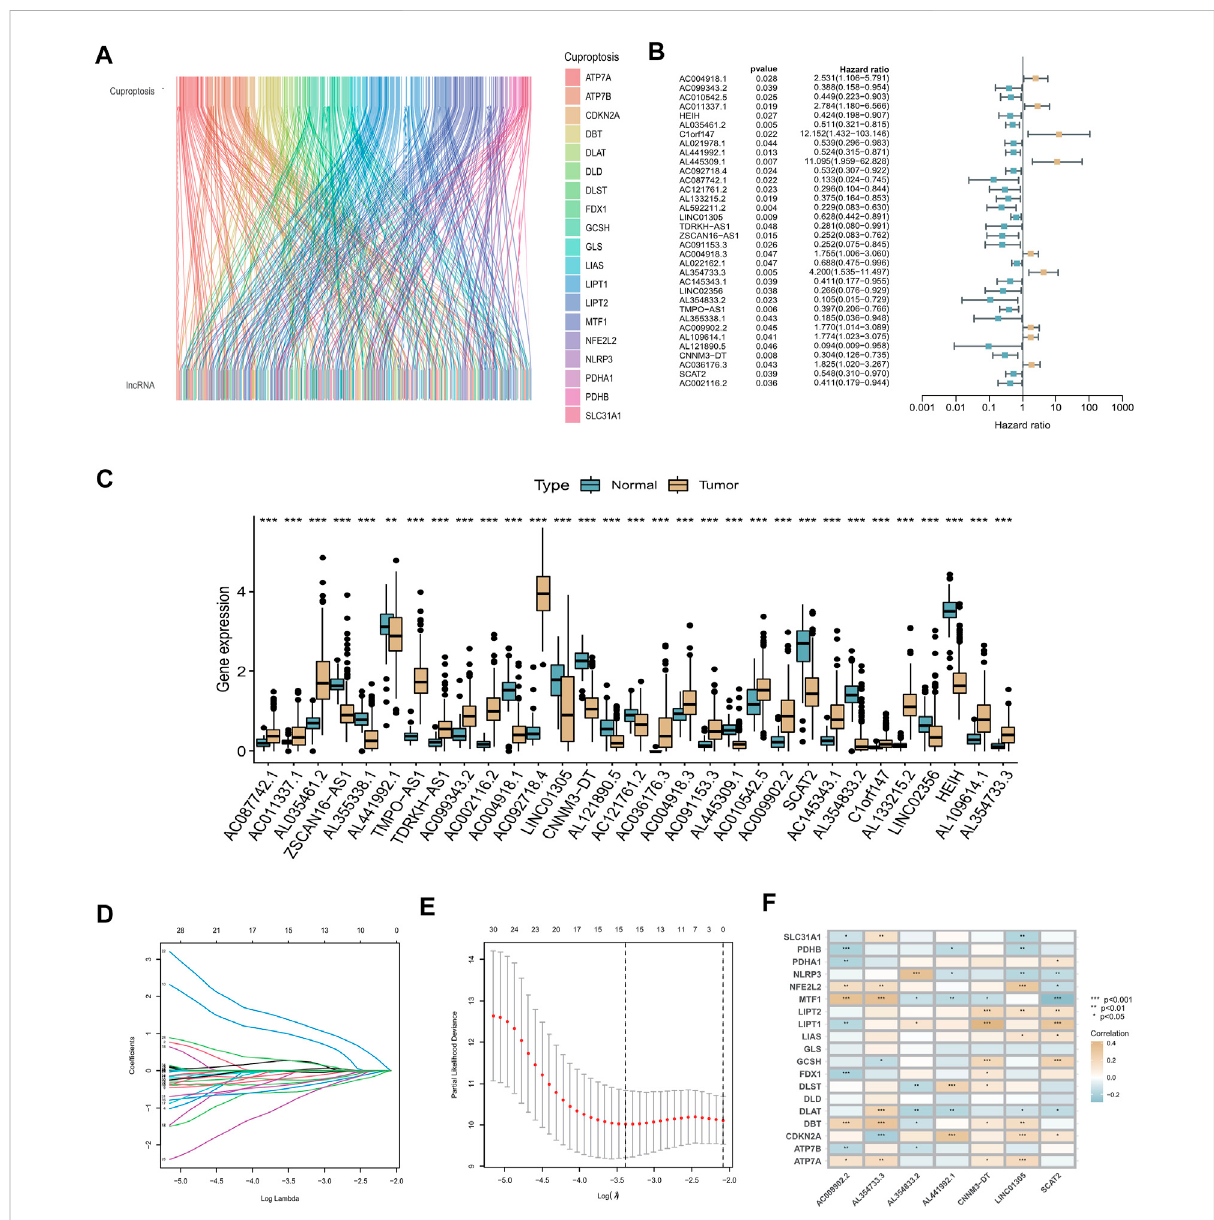
FIGURE 2 Construction of cuproptosis-related lncRNA prognostic signature. (A) Sankey diagram used to visualize the co-expression network of cuproptosis-related lncRNAs. (B) Forest plot representing the results of the univariate Cox regression analysis. (C) Expression levels of 34 cuproptosis-related lncRNAs that differed between tumor tissue and normal tissue. Normal tissue is shown in blue, tumor tissue in yellow. Adjusted p -values are indicated (* p < 0.05, ** p < 0.01, *** p < 0.001). (D) LASSO coef fi cient pro fi les of the 34 cuproptosis-related lncRNAs. (E) Options for the parameter ( λ ) in ten-fold cross-validation. (F) Correlation analysis between the seven cuproptosis-related lncRNAs and 19 cuproptosis-related